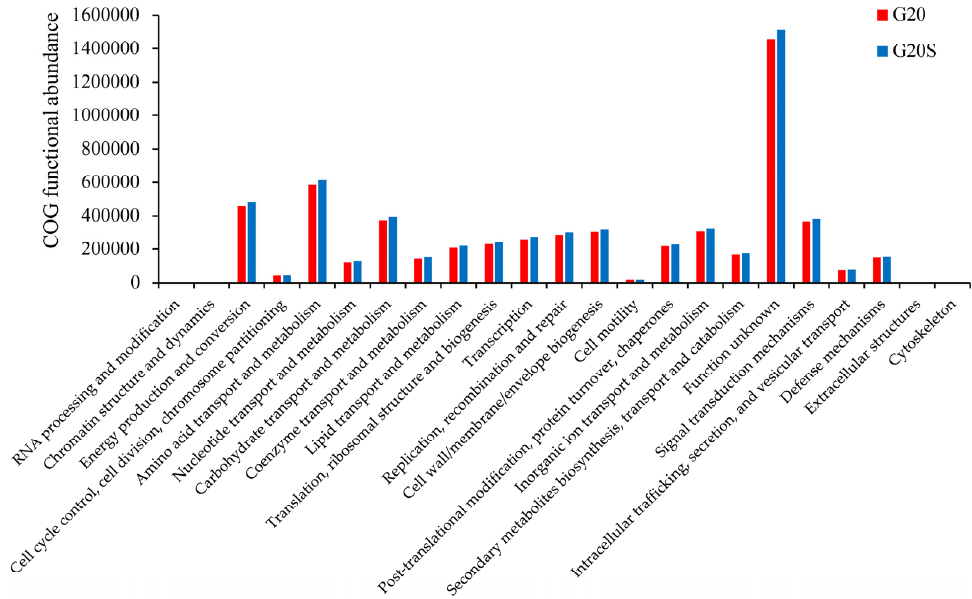
Figure 5. Functional annotation of microbial COG in rhizosphere soil of sweet sorghum between the G20 (noninoculation) and G20S (strain SR-9 inoculation) treatments.